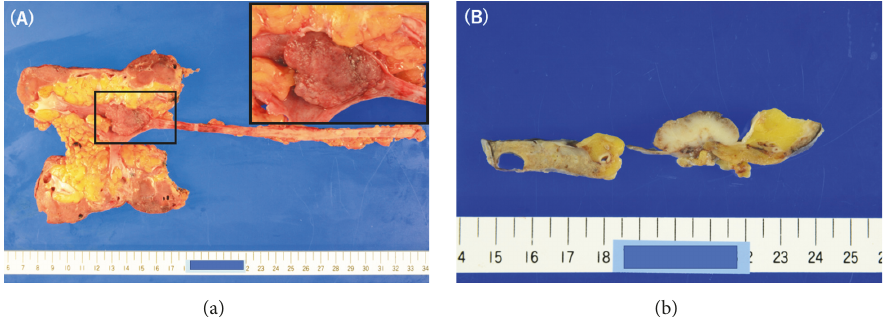
Figure 3: (a) A nodular pedunculated tumor measuring 3.2 ∗ 2.4 ∗ 1.0 cm in the right renal pelvis. Inset, magnified image of the tumor. (b) Gross appearance of formalin-fixed tumor section. Surgical margin was negative